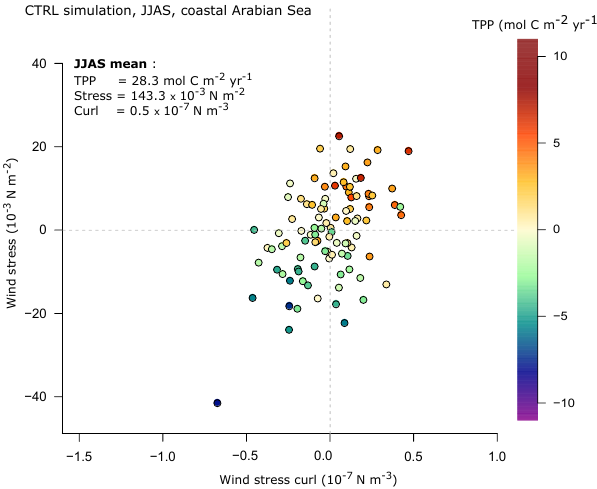
Figure 4. Anomalies of total primary productivity (TPP, molCm − 2 yr − 1 , represented by the colour scale) integrated over the whole water column as a function of wind stress anomalies (10 − 3 Nm − 2 , y axis) and wind stress curl anomalies (10 − 7 Nm − 3 , x axis) in the western coastal Arabian Sea (see Fig. 2a) for the CTRL simulation. Anomalies are computed as the difference be- tween each summer average (JJAS) and the seasonal summer mean of the corresponding variable in the CTRL simulation. The colour of the circles represents the value of the change in TPP compared with the CTRL. The colour scale, x axis range and y axis range are the same as those in Figs. 7 and